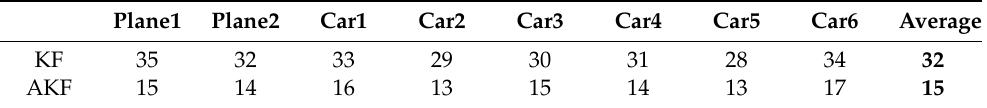
Table 1. Convergence frames of two filters in eight video sequences. The bold values denote the average frame numbers on all video sequences. Plane1 Plane2